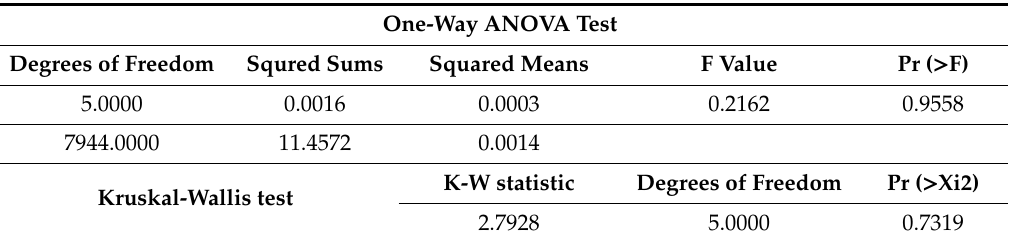
Table 6. ANOVA and Kruskal–Wallis test of the observed weekly returns in the simulated portfolios of the OIL price and the USTBILL